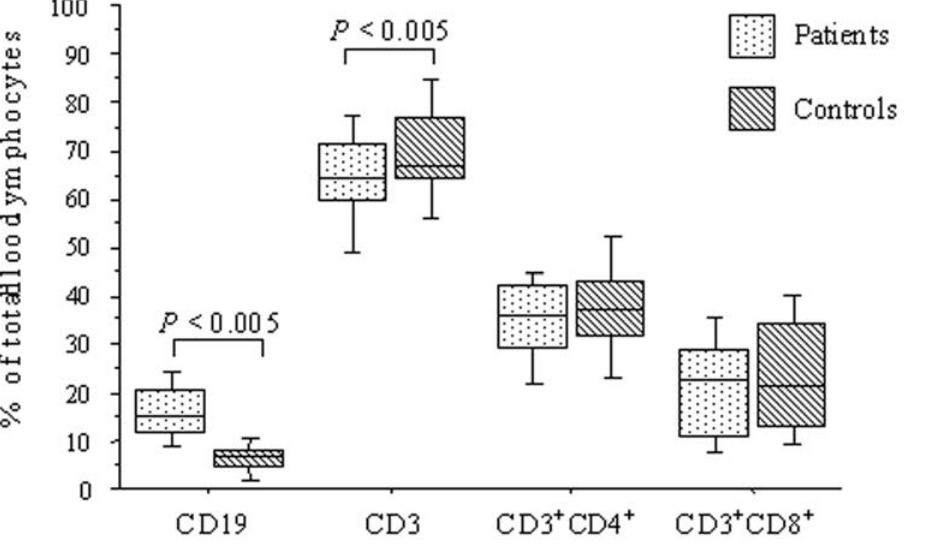
Figure 1. Distribution of B cells (CD19 + ), T cells (CD3 + ), and T-cell subpopulations (CD3 + CD4 + or CD3 + CD8 + ) in the blood of 33 HAT patients and 27 controls (surveys 1 and 2 combined). For each box plot, the features limits correspond, from bottom to top, to the 90 th , 75 th , 50 th (median), 25 th and 10 th percentiles.